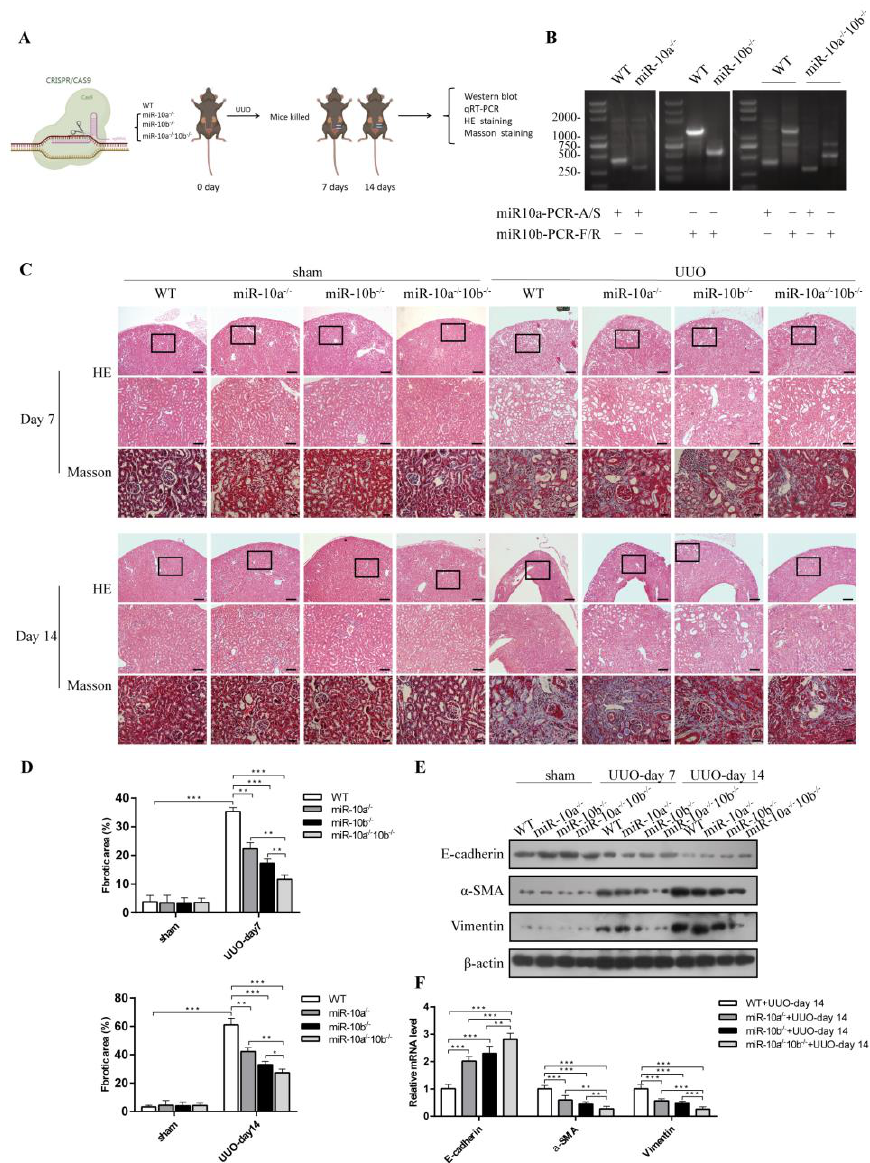
Figure 2. The absence of miR-10a and miR-10b mitigated UUO-induced RF and EMT. ( A ) Schematic diagram of animal experiment process. ( B ) Genotypic identification of knockout mice. ( C ) Represen- tative images of HE (superincumbent image scale bars, 100 µ m; lower image scale bars, 50 µ m) and Masson staining (image scale bars, 20 µ m) in mouse kidneys treated with UUO for 7 and 14 days. Contralateral kidney was used as control. ( D ) Quantitative analysis of blue staining area of fibrosis. At least three random fields were taken from each kidney. ( E ) Western blot for E-cadherin, α -SMA, and vimentin in kidneys. ( F ) RT-qPCR analysis for E-cadherin, α -SMA, and vimentin in mouse kidneys treated with UUO for 14 days. * p < 0.05, ** p < 0.01, *** p <